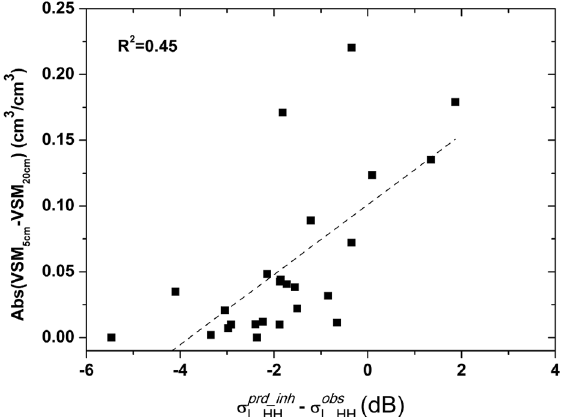
σ − σ and the absolute difference of measured Figure 10. Comparisons between _ prd inh obs L_HH L_HH soil moisture at 5 cm ( VSM 5 cm ) and 20 cm ( VSM 20 cm ) soil measurement depths. The dotted line is the best fit line of the linear regression